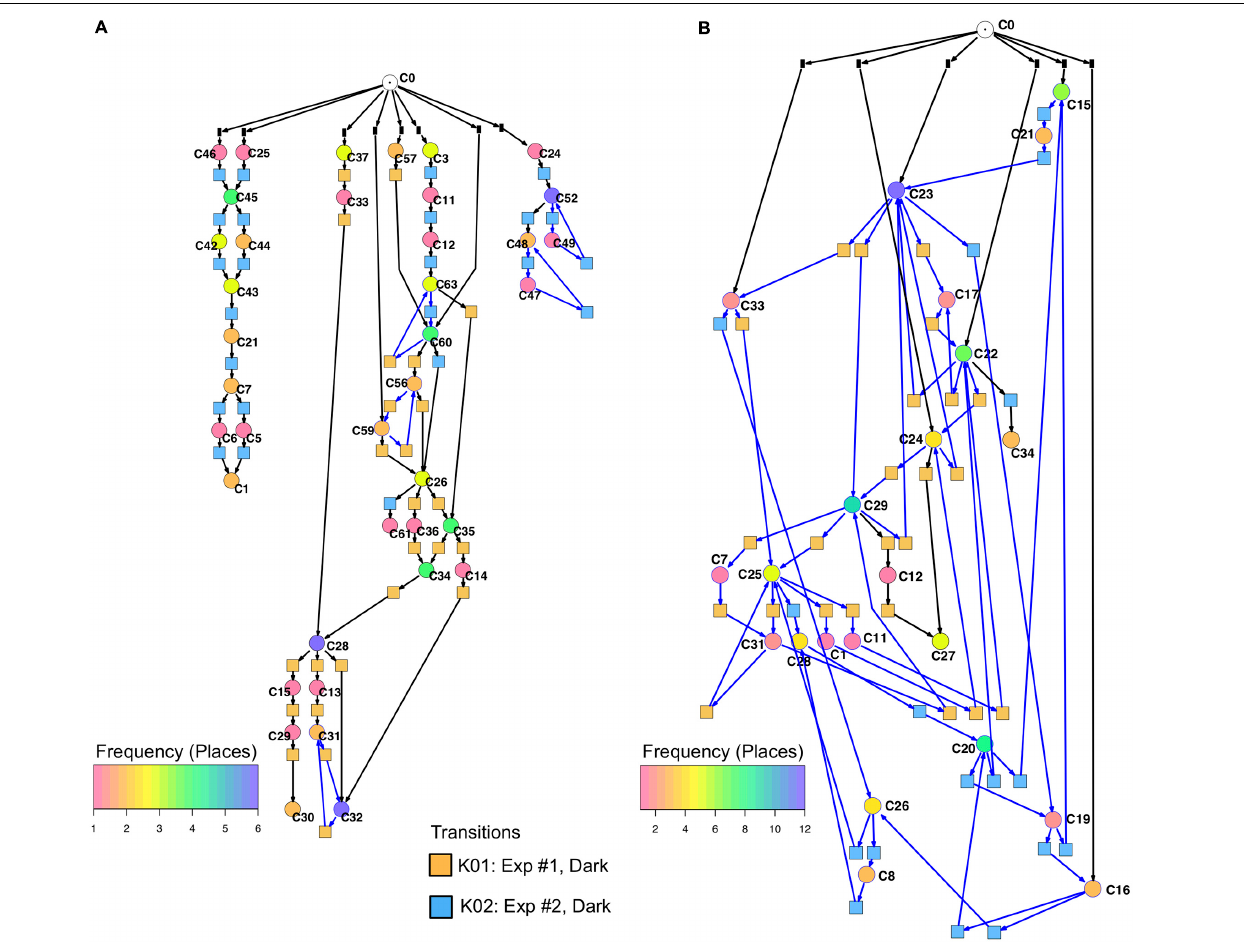
FIGURE 7 | Petri nets constructed for different sets of genes from the gene expression trajectories of un-stimulated cells. (A) Trajectories considering the complete set of 35 genes yield three disconnected Petri nets containing a low number of T-invariants (as indicated by arcs highlighted in blue). (B) When only those genes are considered that are up- or down-regulated in response to far-red stimulation (omitting the pcnA -group of genes), the trajectories of un-stimulated cells give one coherent Petri net which is almost covered with T-invariants. Color coding of places indicates the relative frequencies of states of gene expression in un-stimulated cells. Differences in gene expression patterns of un-stimulated cells between the cells of experiment #1 and #2 are indicated by the appearance of experiment-specific transits and accordingly differently colored